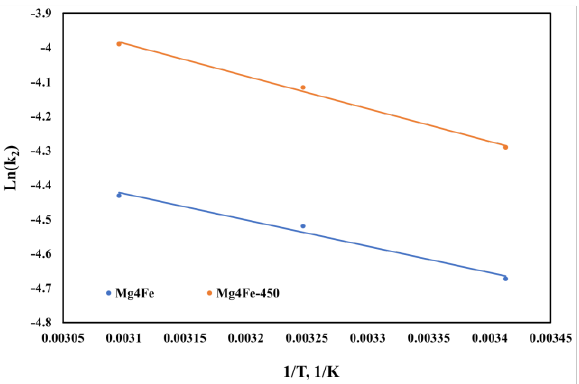
Figure 9. Arrhenius plot of MoO 42 − adsorption onto the studied materials. Table 5. Thermodynamic parameters for Mo(VI) adsorption onto Mg 4 Fe and Mg 4 Fe-450.